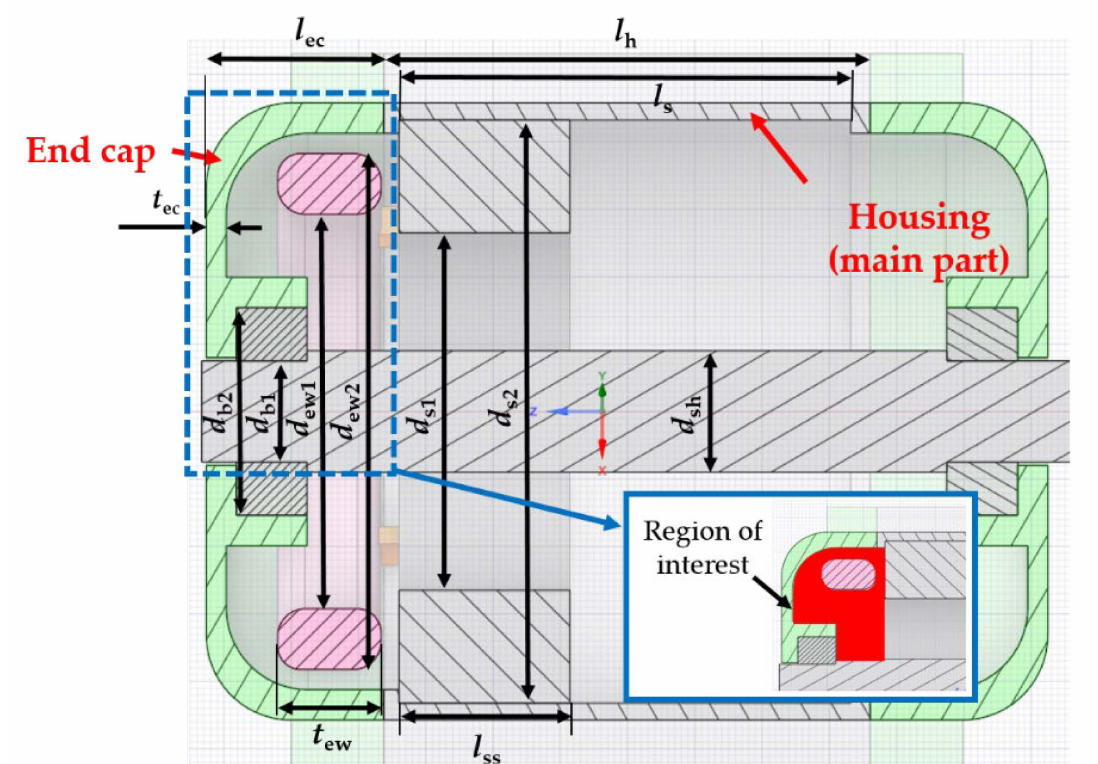
Figure 6. Cross-sectional view of the CFD model with marked geometry